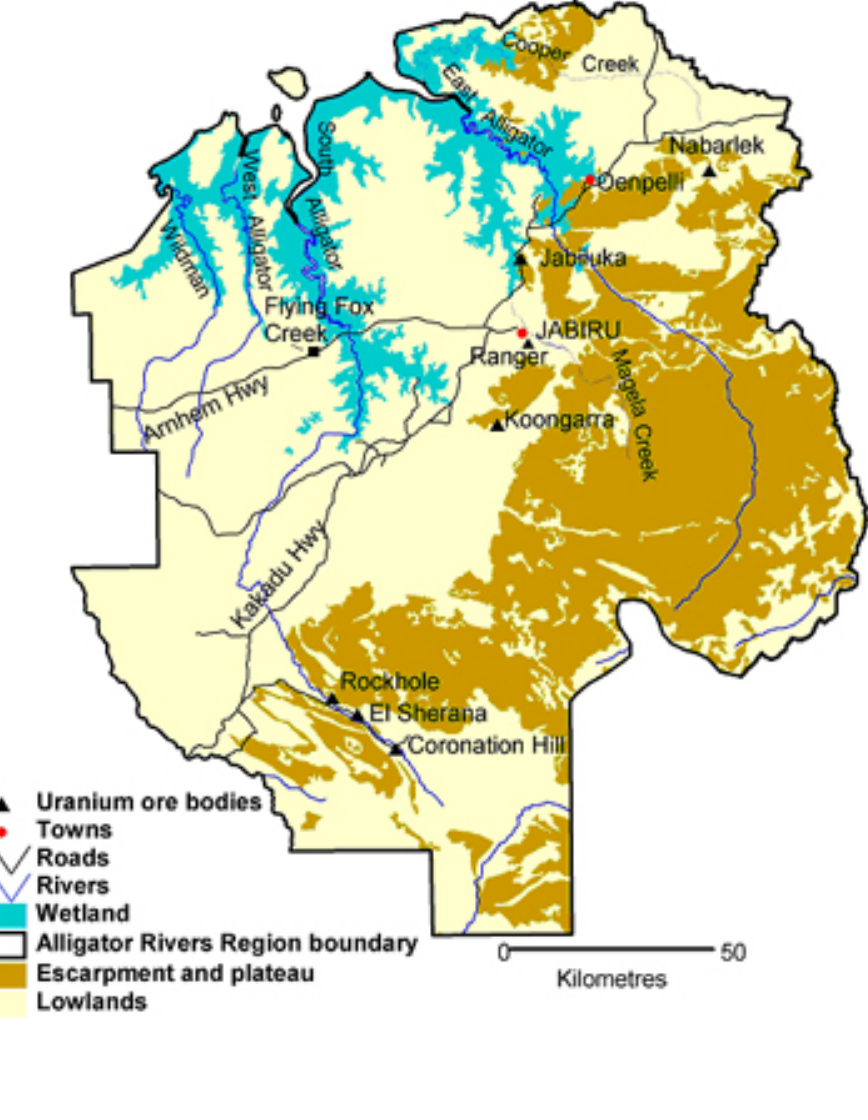
FIGURE 2. The Alligator Rivers